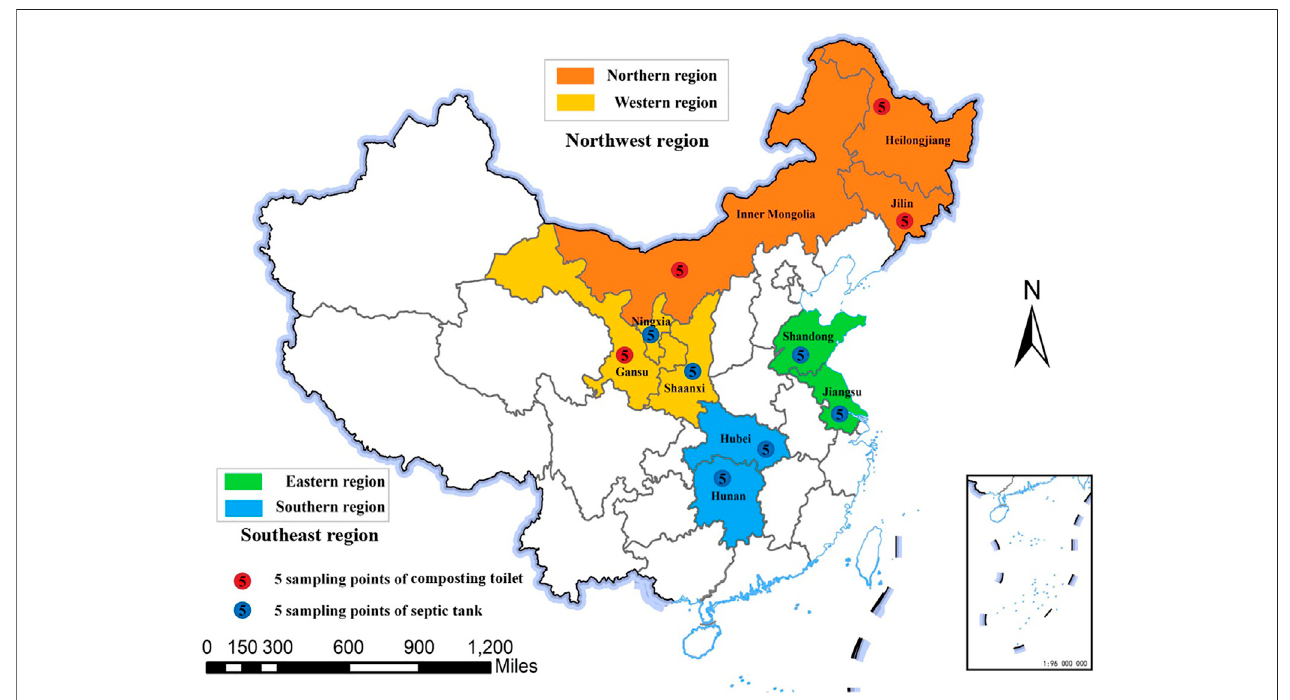
FIGURE 1 | Map of the samples of excrement from 50 rural household